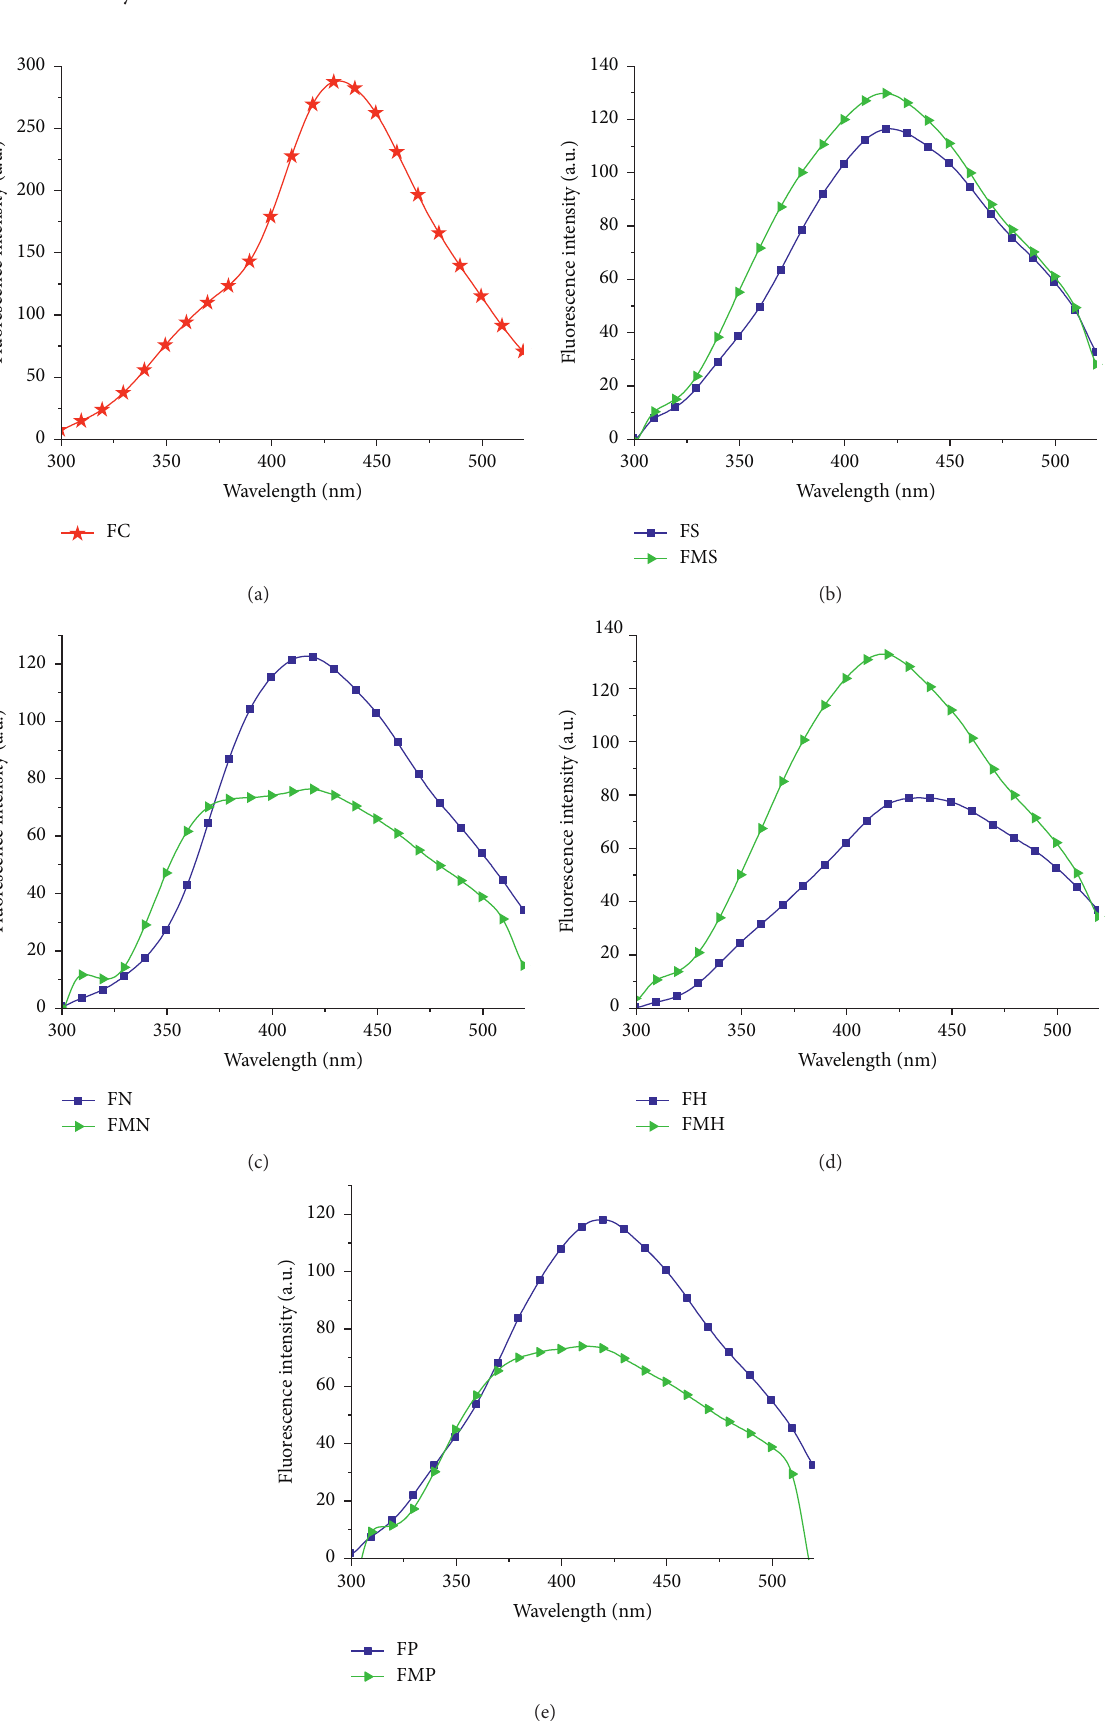
Figure 6: (a) Fluorescence spectrum of fulvic acid. Fluorescence spectrum of fulvic acid by (b) sulfuric acid precipitation, (c) nitric acid precipitation, (d) hydrochloric acid precipitation, and (e) phosphoric acid